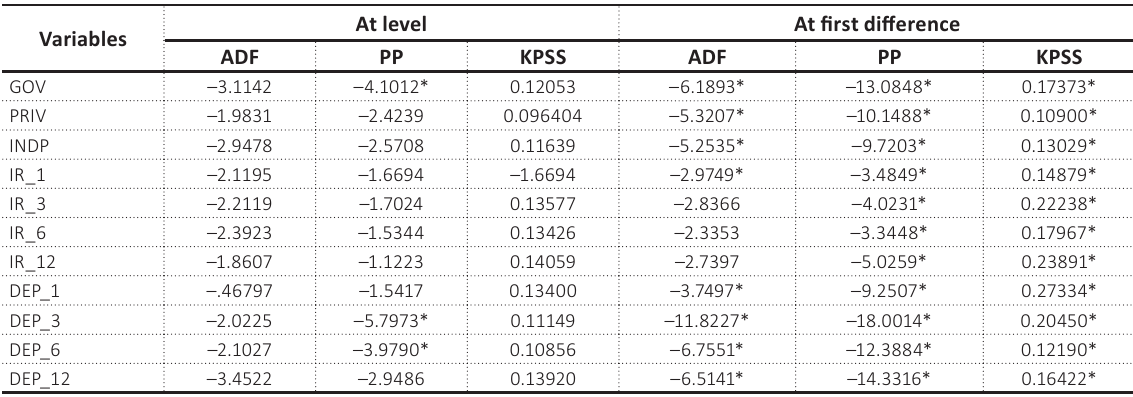
Table 2. Unit root test